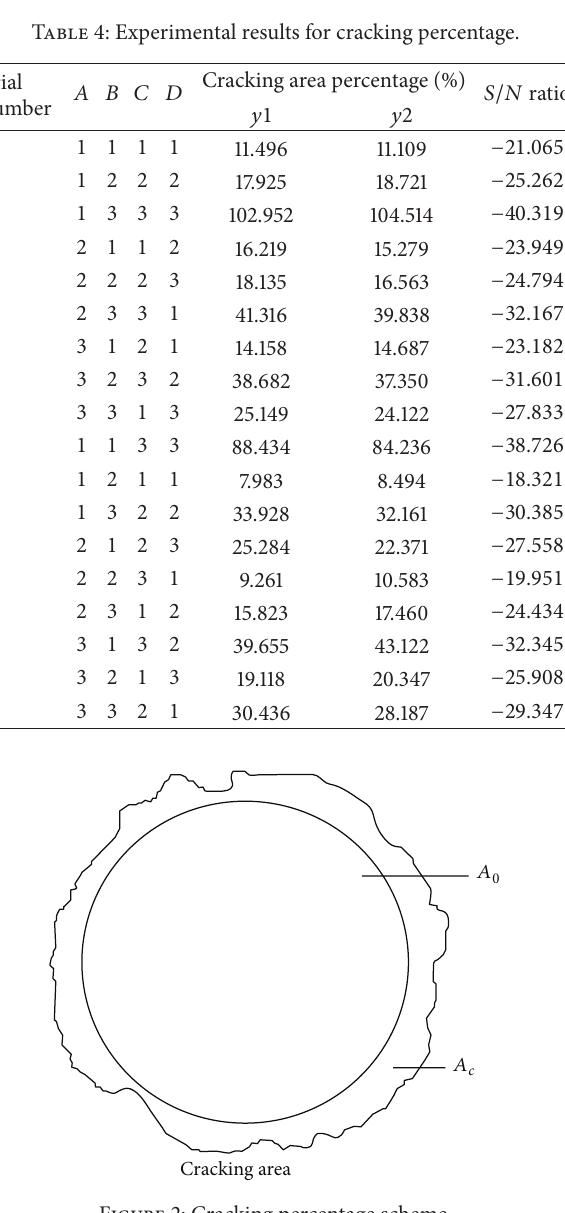
Figure 2: Cracking percentage